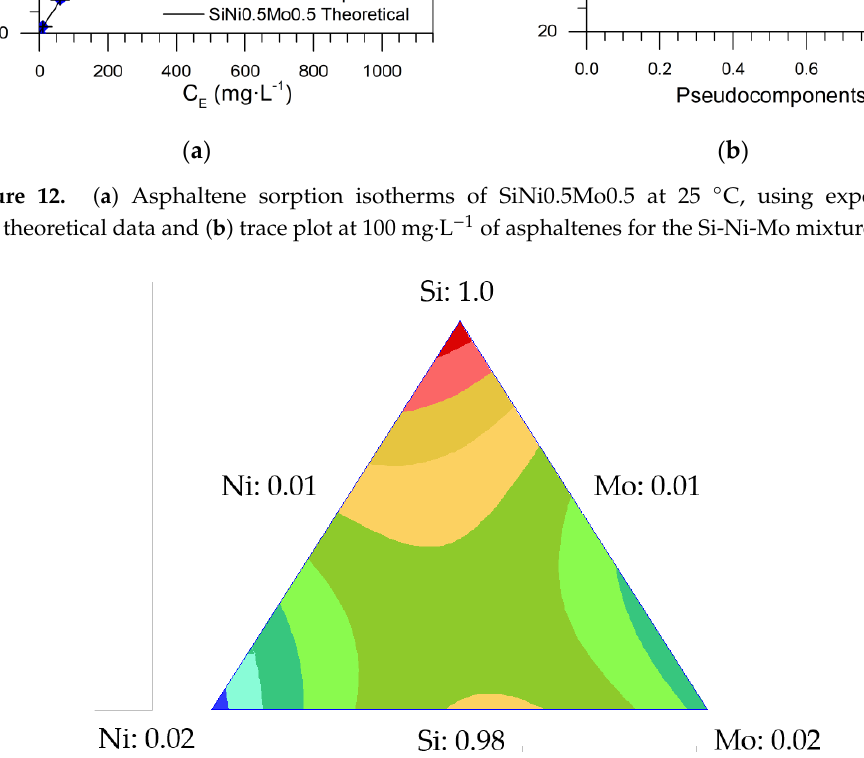
Table 7. Coefficients of the Special Cubic Model for the Si-Fe-Ni-Mo mixture.